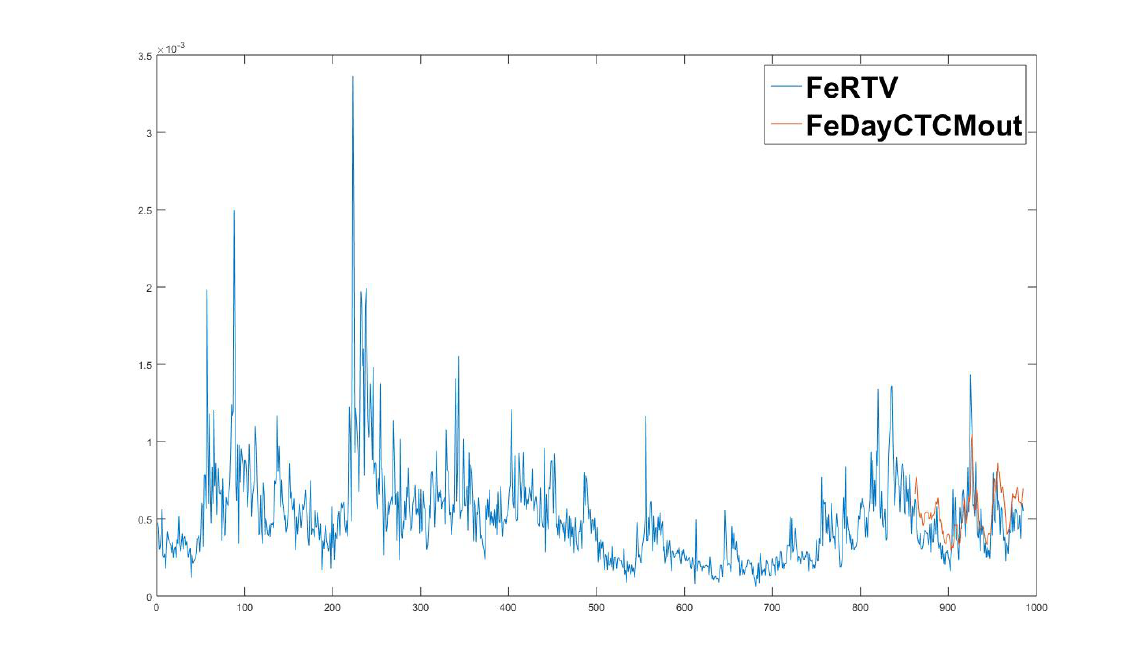
Figure 7. Model CTCM-RTV-D Forecast for I(DCE). The horizontal line is the timeline, and the perpendicular line is the volatility estimator. The forecasted period is the last 124 days. The actual values are represented by the blue line, while the forecasted values are represented by the orange line. The forecasted values are a bit higher than the actual values in most time.